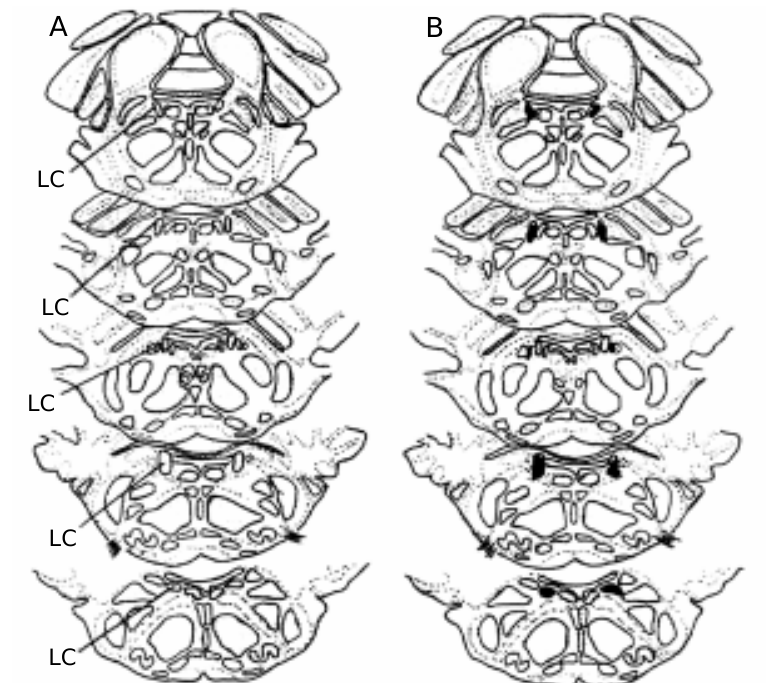
Figure 1 - Representative drawings showing the lo- calization of the locus coe- ruleus (LC) (A) and lesions (dark areas, B) placed bi- laterally in the nucleus. Sequential sections of seven different